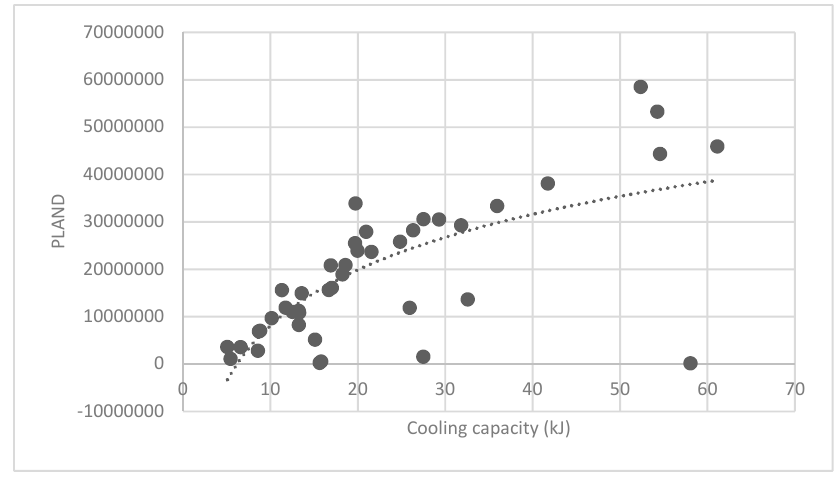
Figure 13. Association between forest land PLAND index and oxygen cooling capacity.